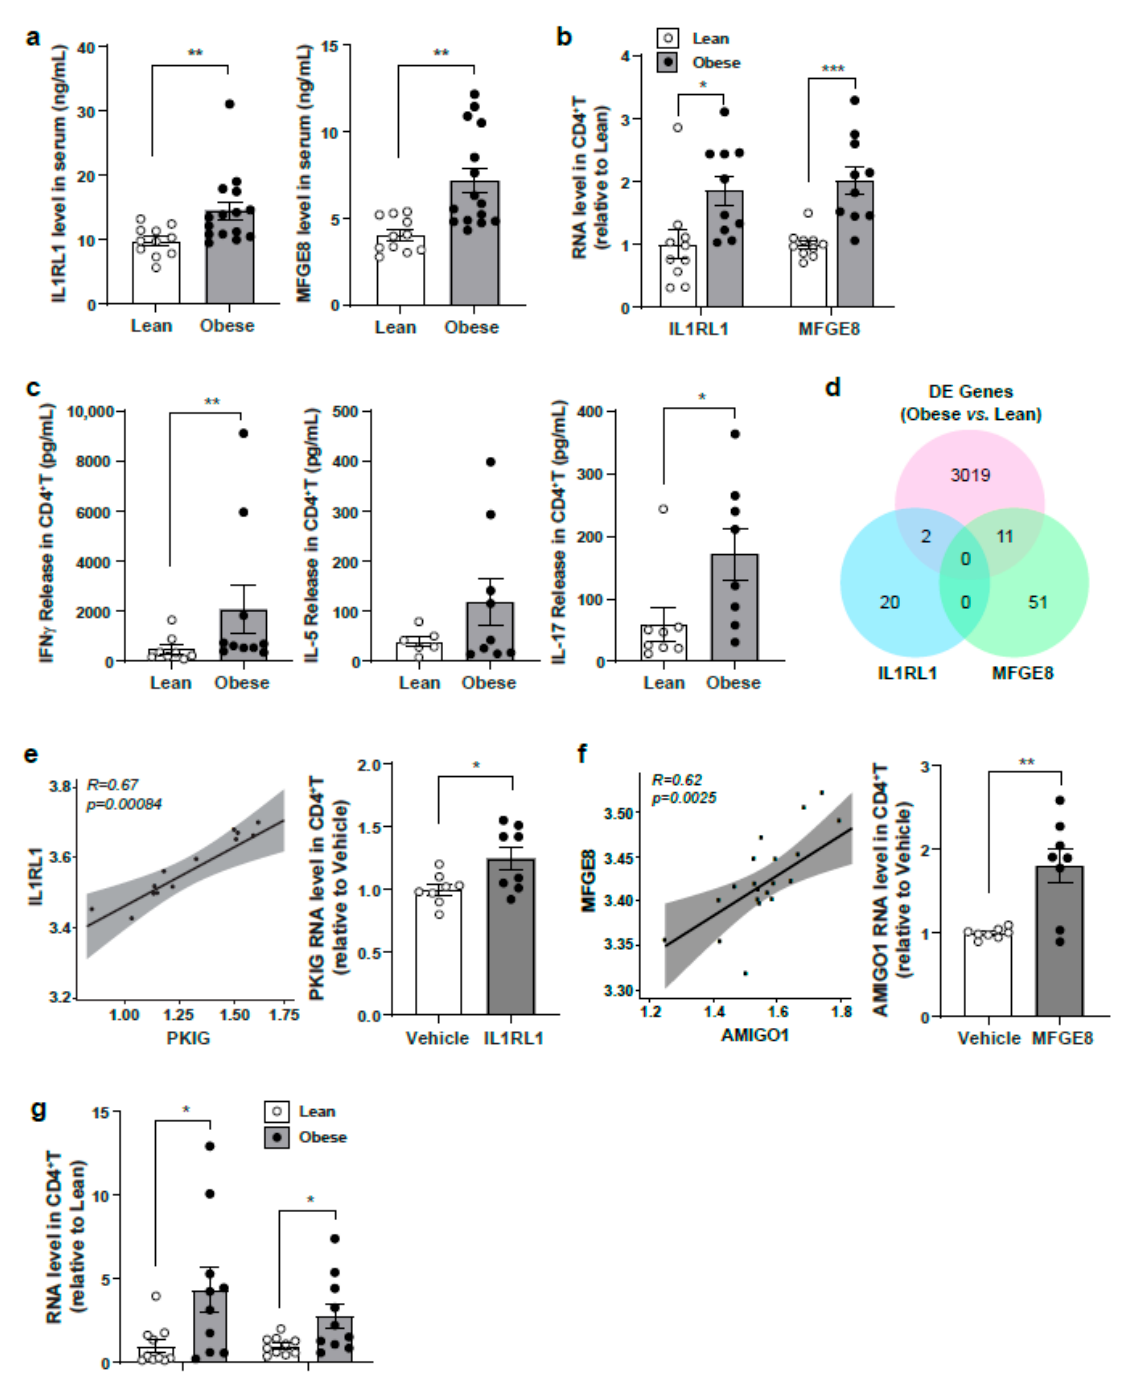
Figure 6. Evaluate the level of fasting serum targets comparing lean to obese subjects. ( a ) IL1RL1 and MFGE8 levels in the serum of lean ( n = 11) and obese subjects ( n = 15). Data point of each subject is shown as dot and quantitative data are presented as means ± SEM. Unpaired student t -test, ** p < 0.01. ( b ) RNA expression in CD4 + T cells from lean and obese subjects ( n = 10). Data point of each subject is shown as dot and quantitative data are presented as means ± SEM. Unpaired student t -test, * p < 0.05; *** p < 0.001. ( c ) Cytokine release in CD4 + T cells from lean and obese subjects (lean, n = 6–8; obese, n = 8–10). Ratio paired Student t -test, ** p < 0.01. ( d ) IL1RL1- and MFGE8-correlated genes (IL1RL1, 4 genes; MFGE8, 62 genes) from the fasting-refed RNAseq dataset were used as the discovery cohort. The expression levels of these genes were found in the lean-obese RNAseq dataset (IL1RL1, 2 genes; MFGE8, 11 genes), * p < 0.05. ( e , f ) Integration plot with IL1RL1 or MFGE8 serum protein and correlated genes (left panel) and transcript level correlated with IL1RL1 or MFGE8 in CD4 + T cells (right panel, n = 8), * p < 0.05; ** p < 0.01. ( g ) RNA expression in CD4 + T cells from lean and obese subjects (lean, n = 8; obese, n = 10). Unpaired Student t -test, * p <